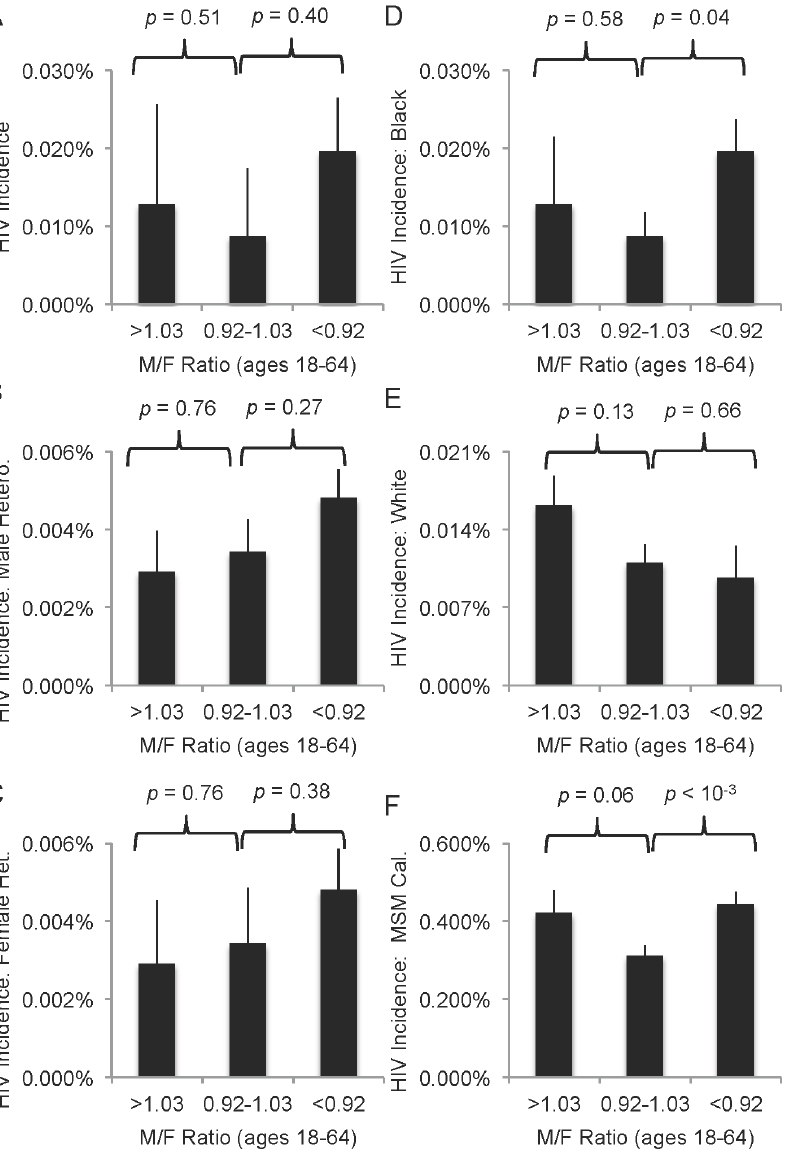
Figure 4. Association of HIV and skewed male:female ratios supports effect of such ratios on partner concurrency. M:F ratios were calculated as the total number of male individuals aged 18–64 divided by the total number of female individuals aged 18–64 for each city. Groups were established as deviating . 0.05 from the mean M:F ratio (0.97) and p values are for T-tests between extremes (n=24 for , 0.92 and 13 for . 1.03) and mid-range (n=43). A. Total reported HIV incidence per city varies by M:F ratio, but not significantly. B–C. HIV incidence reports amongst ( B ) males and ( C ) females exposed by heterosexual contact. D–E. HIV incidence among ( D ) black or ( E ) white individuals. F. HIV incidence reports by MSM exposure only, as a percentage of estimated number of GLB individuals per city.